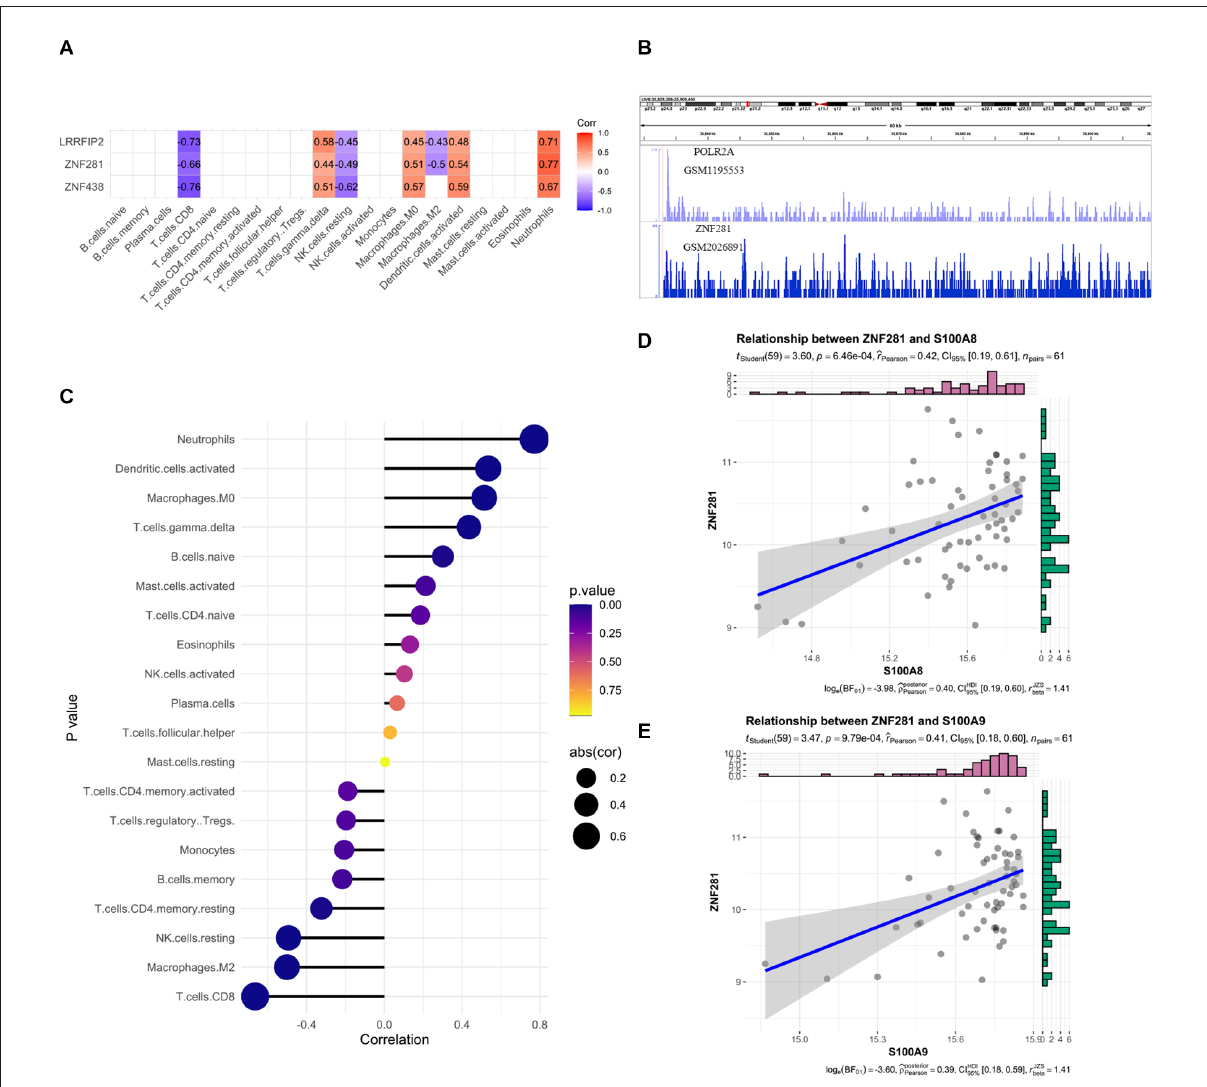
FIGURE6 (A) The correlation heatmap visualized the relationship between transcription factor (TF) which may regulate SRPK1 expression and immune cells. (B) The loci of ZNF281 and POLR2A at chromosome 6 indicates ZNF281 binds to the promoter of SRPK1. (C) Relationships among infiltration levels of 22 immune cell types and ZNF281 expression profiles by Spearman’s analysis. (D,E) Correlation of marker gene of neutrophils: S100A8 and S100A9 with ZNF281. The correlation coefficient was 0.42 ( p < 0.001) and 0.41 ( p < 0.001)